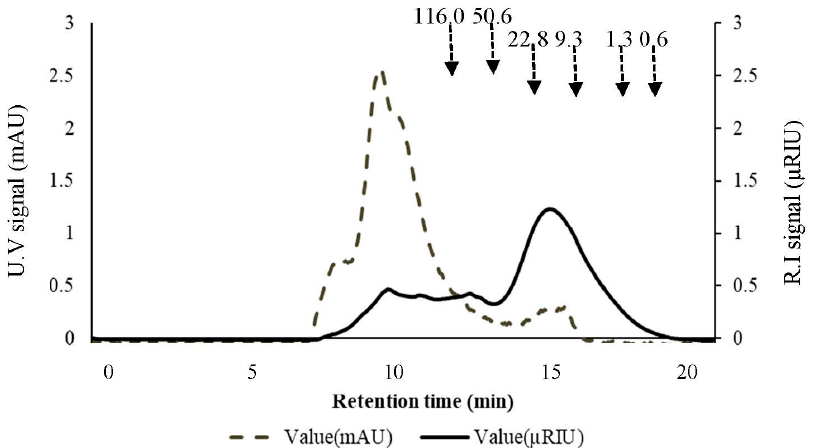
Figure 1. Size exclusion chromatography of adsorption preparation (AD). The analytical separation was achieved using Shodex, SB-803-HQ column (Shodex, Tokyo, Japan) with a variable wavelength UV detector (mAU) at 280 nm (Thermo Fisher, Waltham, MA, USA) and RI 101 detector ( µ RIU) (Shodex, Tokyo, Japan). Water was used as an eluent at a flow rate of 0.5 mL/min, the substrate was used at 1 mg/mL of GGM, and the temperature was maintained at 25 ◦ C. Arrows (dashed) mark the peak maximum of pullulan standards (kDa). The RI peak maximum (solid arrow) was used to estimate the apparent molecular weight of the AcGGM product, based on the logarithmic calibration curve of the pullulan